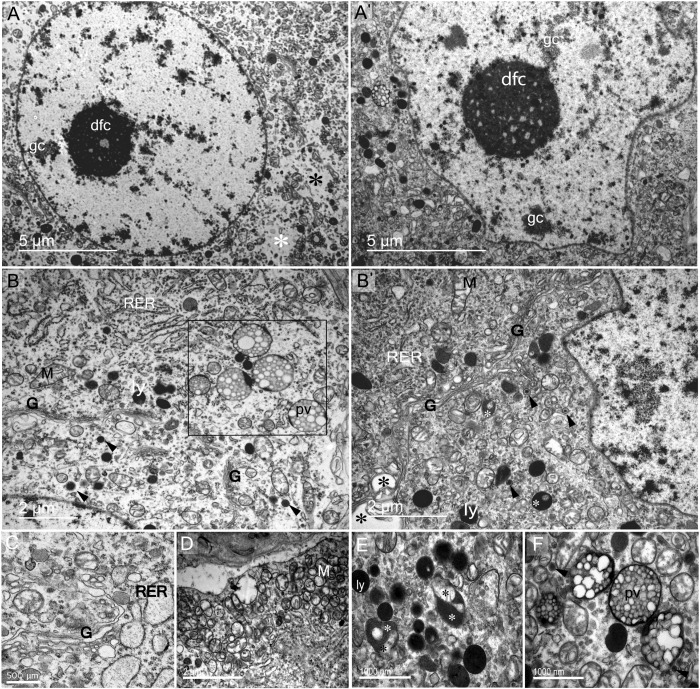
Ultrastructural description of SON magnocellular neurons and their subcellular elements in the somatic zone.Light (lMN) and dark (dMN) magnocellular neurones are morphologically distinct. The nuclei of lMN (A) and dMN (A') are different in shape, respectively rounded and indented. However, both contain dense fibillary condensed (dfc) and granular chromatin (gc). The cytoplasm of the IMN is less loaded (asterisks in A) than that of the dMN. (B-B') Both lMN and dMN showed high activity as reflected by the presence of a well developed machinery of neurosecretion and recycling. Rough endoplasmic reticulum (RER), Golgi apparatus (G), mitochondrion (M), polyvesicular body (pv), lysosomes (ly) and dense core secretory granules (arrowheads; 195.71 nm ± 4.02 and 157.5nm ±3.65) are the main membranous structures found at the subcellular level of MNs. The rough endoplasmic reticulum (RER) was abundant and was present in different degree of dilation (B,C). The rectangle in panel (B) identifies several phagosomes (polyvesicular bodies) with vesicles of heterogeneous size. The Golgi apparatus is scattered as discontinuous (B) or well developed continuous (C). (D) Cluster of mitochondria (M) observed close to plasma membrane. (E) Lysosomes (ly) and autophagosomes (white asterisks), internalizing cytoplasmic membranous structures (black asterisks). (F) Polyvesicular bodies containing heterogeneous vesicles.